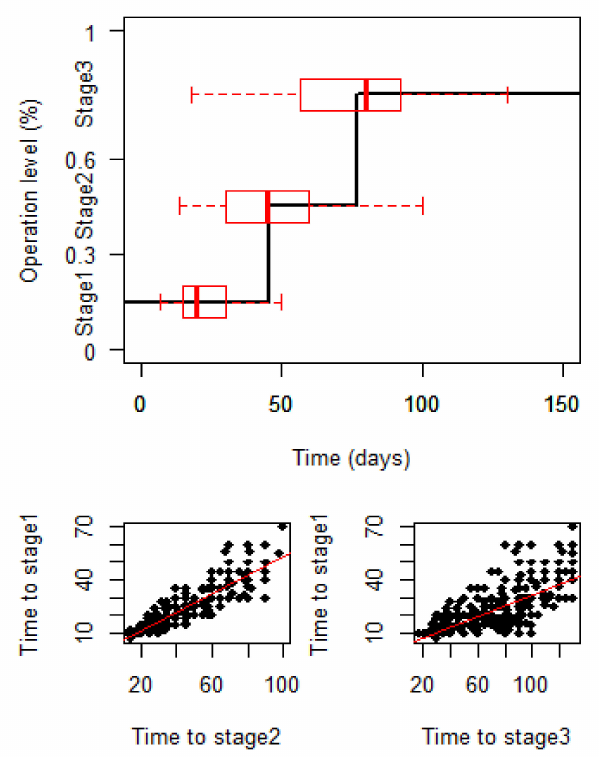
Figure 1. Initial recovery and complete